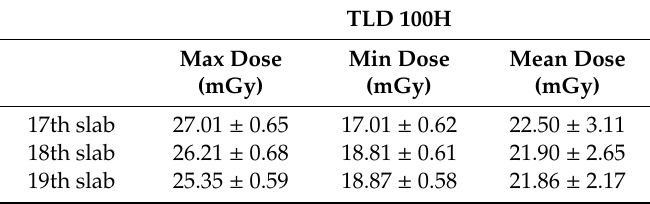
Table 4. Maximum, minimum and average dose value measured with TLD 100H for the 17th, 18th and 19th slab.